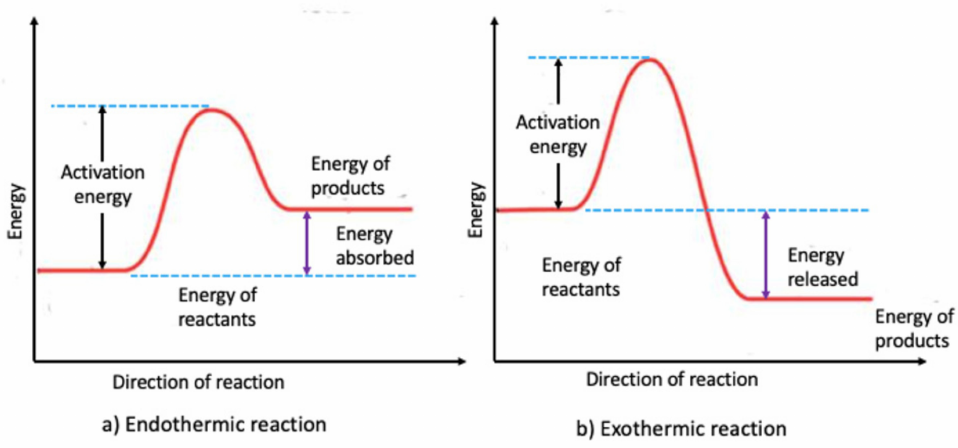
Figure 8. Schematic showing the energy interaction during endothermic and exothermic reactions: ( a ) Endothermic reaction- energy of products is higher than energy of reactants and ( b ) Exothermic reaction- energy of products is less than energy of reactants [42].